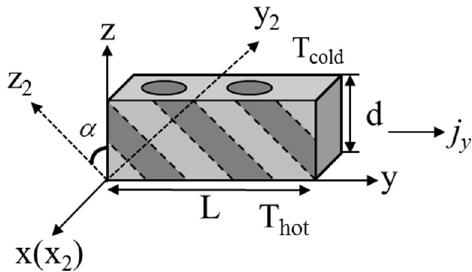
Figure 3. Schematic showing a piece of the fibrous composite tilted on an angle α about the x-axis.